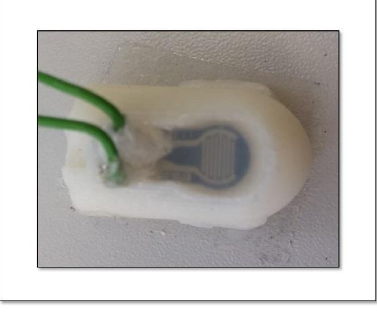
Figure 10. Example of the fingertip embedding the immersed sensor with the silicone layer on top. Table 7, left panel reports the experimental results: it can be notice that the repeatability of the measurement has significantly improved when compared to the same load applied to the sensor without any silicone. Similar results were obtained with the Deep3R8 configuration (right panel of Table 7).